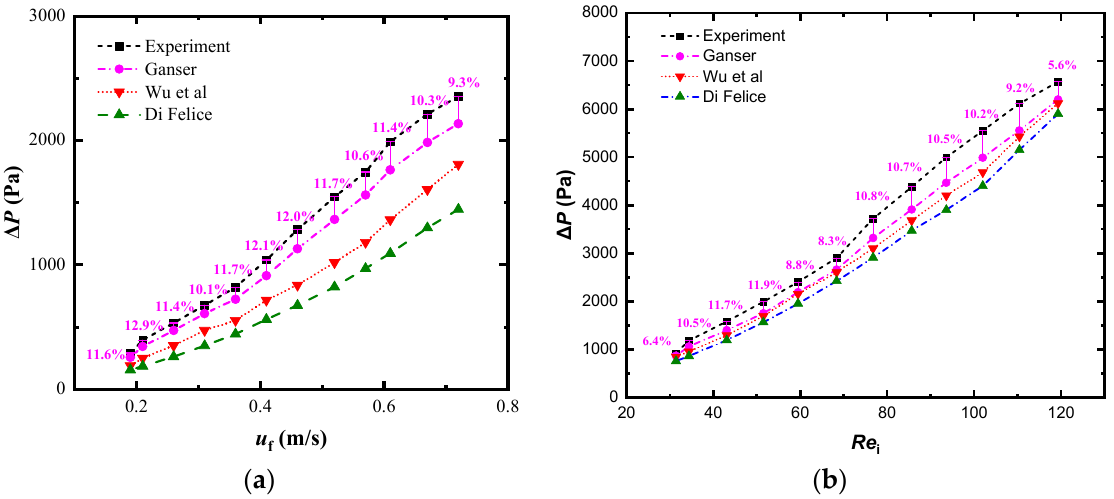
Figure 6. Comparison of pressure drop for two cylindrical particles with the Di Felice model and Ganser model: ( a ) 0.00498 d and 0.0139 L ; and ( b ) 0.00198 d and 0.00495 L . To further improve the Ganser model so that it can give more accurate drag force prediction for cylindrical particles, a correction factor K ′ is added in the Ganser drag co- efficient as shown in Equation (25). The fitting method is used to find the relationship between K ′ and the particle Reynolds number. The expression of the cylindrical particle drag coefficient ( C dc ′ ) is: